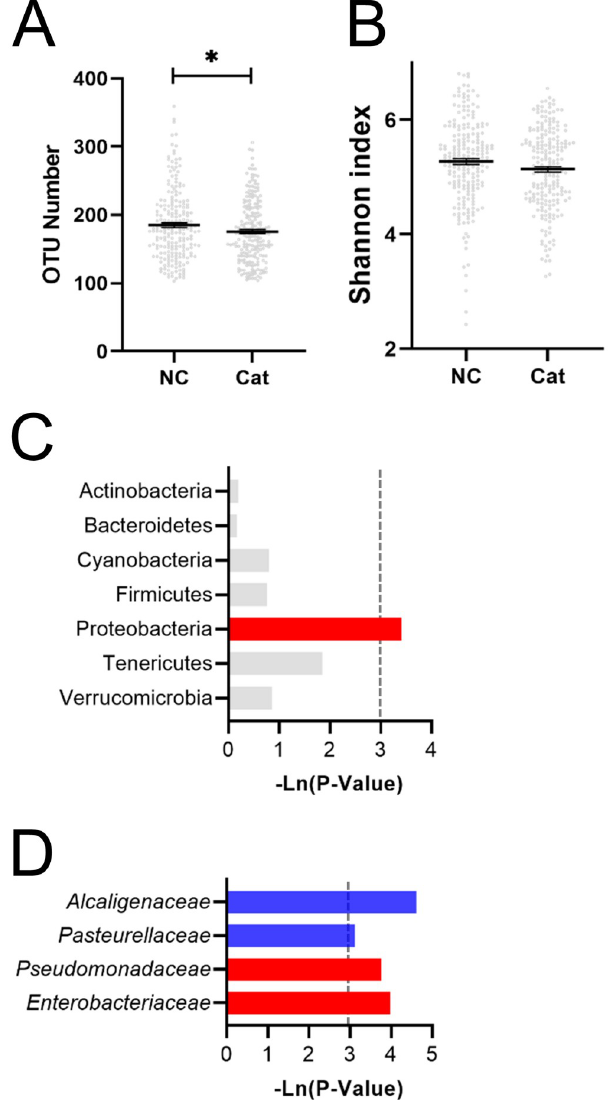
Fig 1. The effect of cat ownership on the composition of the microbiota of all individuals. Cat ownership did not affect the (A) number of OTUs or the (B) Shannon index. The effect of cat ownership on bacteria at the (C) phylum level and (D) family level. The red bar represents a significant increase, while the blue bar represents a significant decrease.